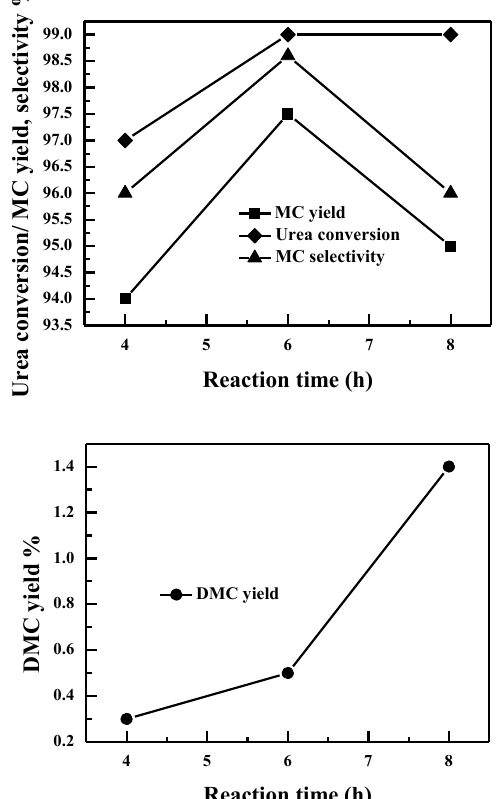
Figure 11. Effect of reaction time on urea conversion, yields of 1 and 2 , and selectivity for 1 . Urea 1 g, methanol 13.5 mL, 0.1 g 2.9 wt% TiO 2 /SiO 2 -500, 170 ◦